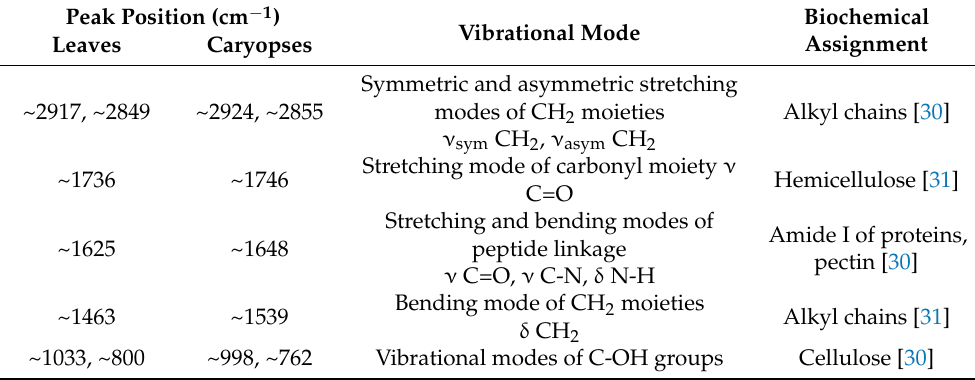
Figure 3. Average absorbance spectra of ( A ) durum wheat leaves collected at the tillering phase (ZS 22), stem elongation phase (ZS 35) and anthesis phase (ZS 60); ( B ) durum wheat caryopses collected at the anthesis phase (ZS 60) and ripening phase (ZS 92). Spectra are reported in the 4000–650 cm − 1 range and are shifted along the y -axis for clarity. The position of the most relevant peaks is reported in terms of wavenumbers (ZS refers to the Zadoks scale). Table 3. Meaningful IR peaks of samples of durum wheat leaves and caryopses: peak position (in terms of wavenumbers, cm –1 ), vibrational mode and biological